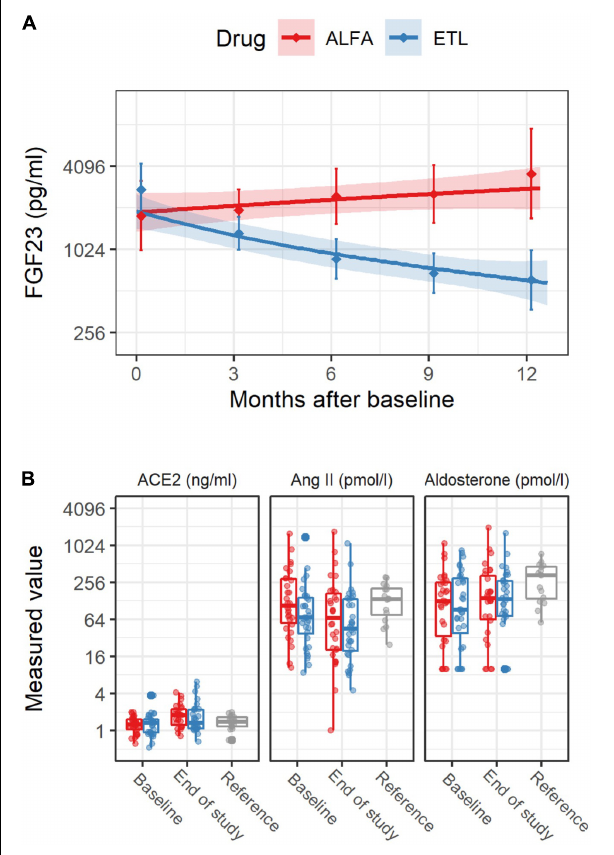
FIGURE 2 | FGF23 levels [upper panel (A) ] and renin-angiotensin-aldosterone system (RAAS) levels [lower panel (B) ] over the study period, stratified by study drug. In panel (A) , the solid line was derived from a linear regression model for the log2 transformed FGF23 levels including measurement time as covariate. The shaded area depicts pointwise 95% confidence intervals for the predicted means at the given points in time. The diamonds and vertical bars at time 0 depict median and interquartile range for baseline FGF23 levels. The corresponding diamonds and vertical bars at later times summarize values from baseline to 3 months, from 3 to 6 months, and so on. In the panel (B) for RAAS levels depicted by boxplots, “Reference” refers to the RAAS values from a group of healthy male individuals, which were not part of this study, but are shown for comparison. Individual measurements are drawn as